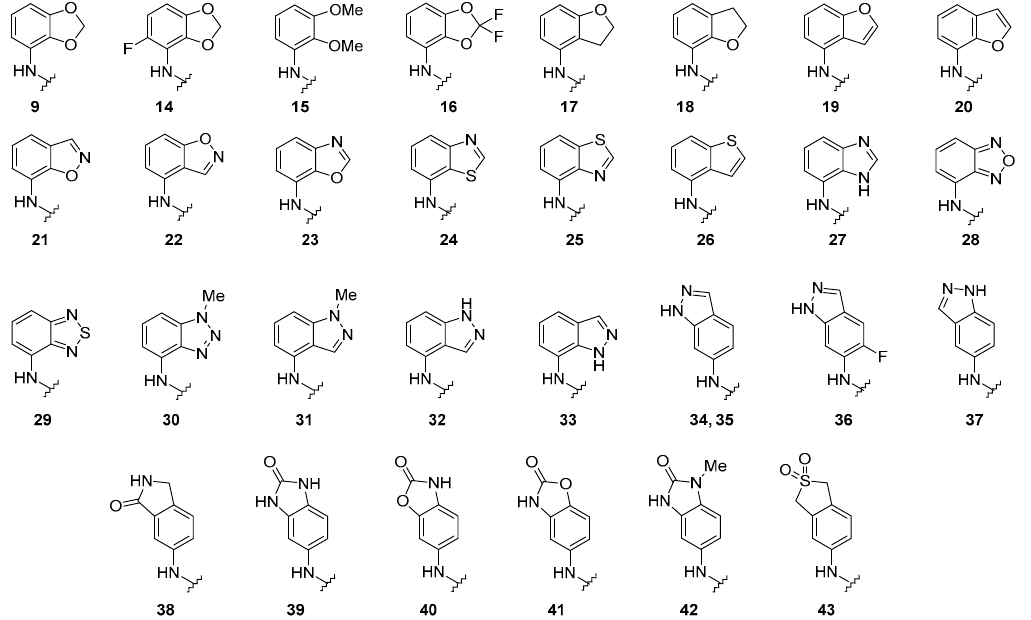
Figure 4. Aniline fragments incorporated into compounds 9 and 14 – 43 in Table 3.